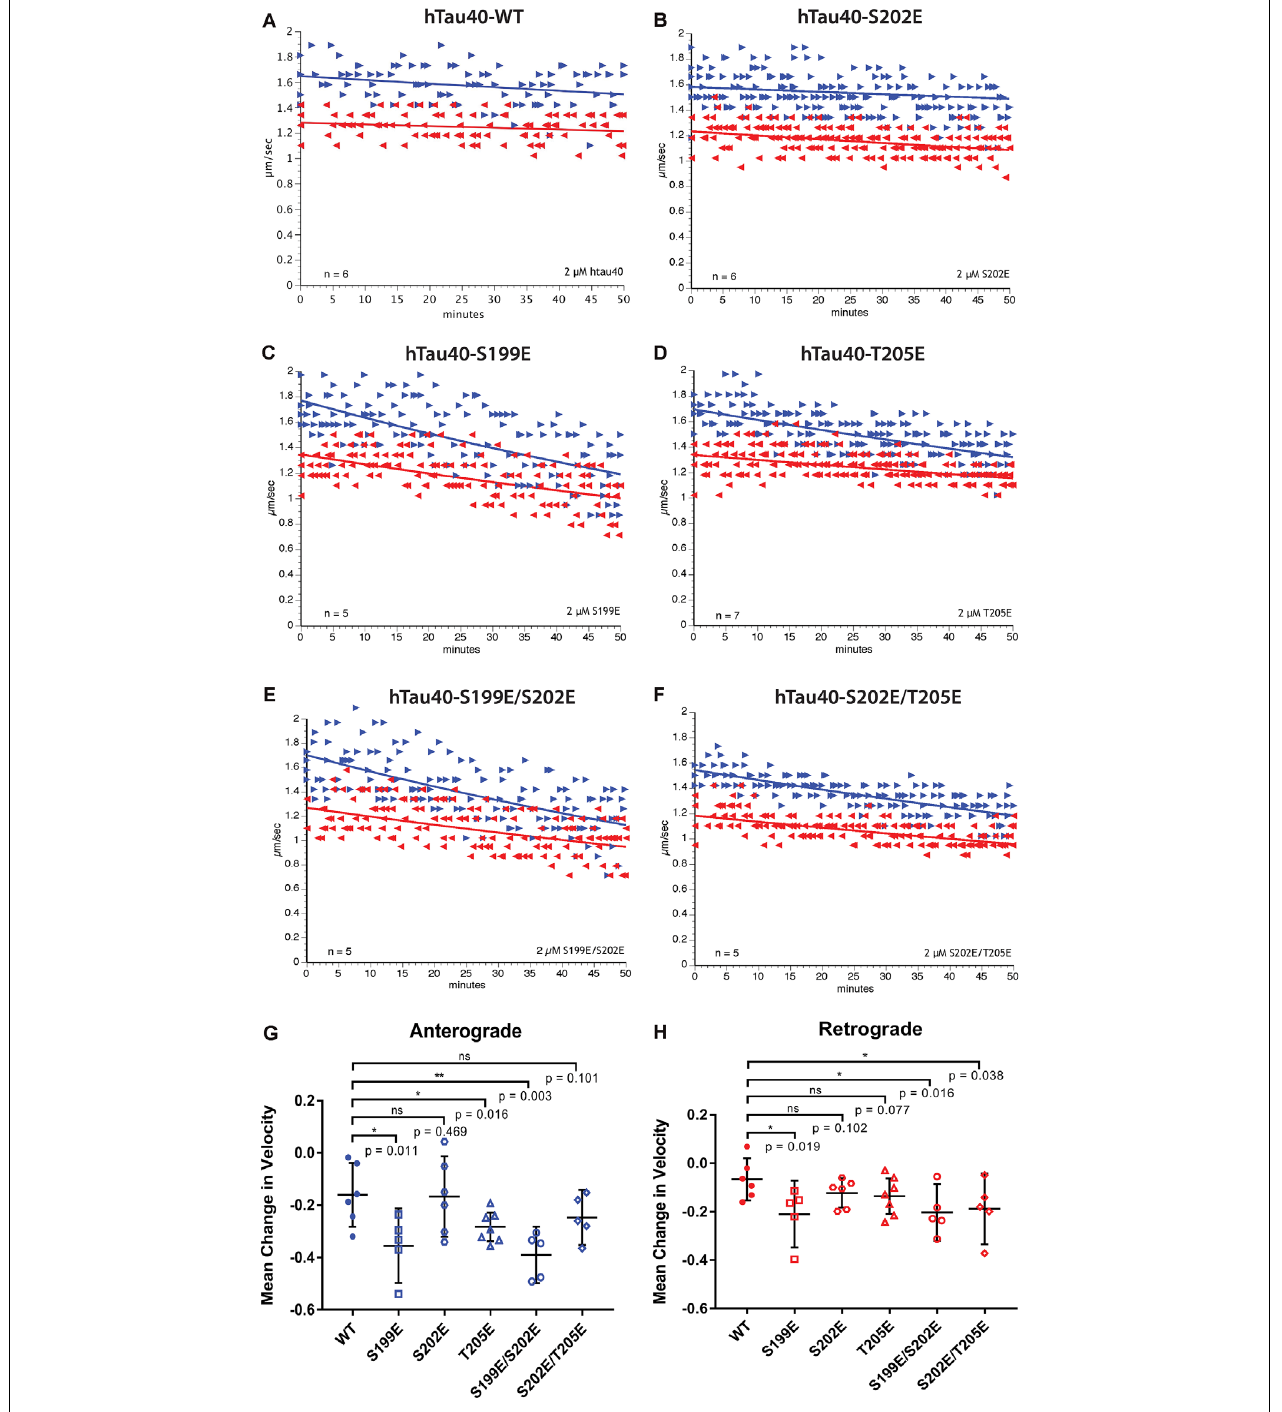
FIGURE 2 | Differential phosphorylation of tau within the AT8 epitope can inhibit either anterograde or both directions of fast axonal transport (FAT). (A–F) The vesicle motility assay in isolated squid axoplasm is an ex vivo model system that allows for simultaneous, quantitative analysis of anterograde and retrograde FAT (Song et al., 2016). Graphs are plotted as velocity ( µ m/s) against time with right arrows ( (cid:73) ) indicating anterograde data points and left arrows ( (cid:74) ) indicating retrograde data points. (A) Perfusion of WT tau monomers did not affect the rate of axonal transport in either the anterograde or retrograde direction. (B) hTau40-S202E monomers were not sufficient to inhibit FAT in either the anterograde or retrograde directions. (C) In contrast, Tau monomers pseudophosphorylated at serine 199 (hTau40-S199E) inhibited FAT in both directions, whereas (D) pseudophosphorylation of tau monomers at threonine 205 (hTau40-T205E)